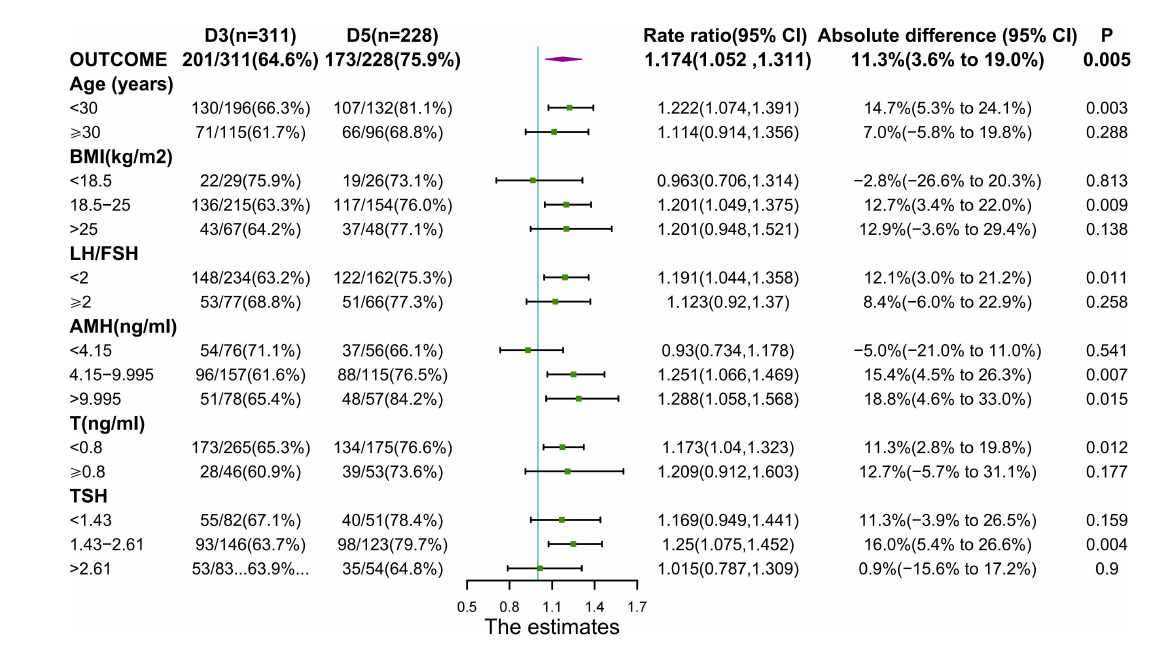
FIGURE 2 Outcomes with Regard to Conception